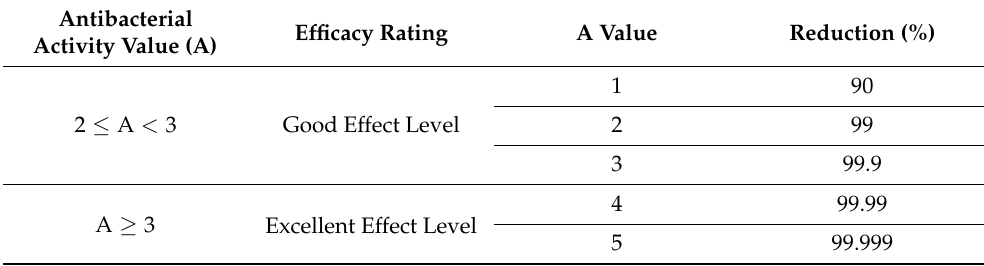
Table 2. Antibacterial activity rating associated with percentage reduction of bacterial